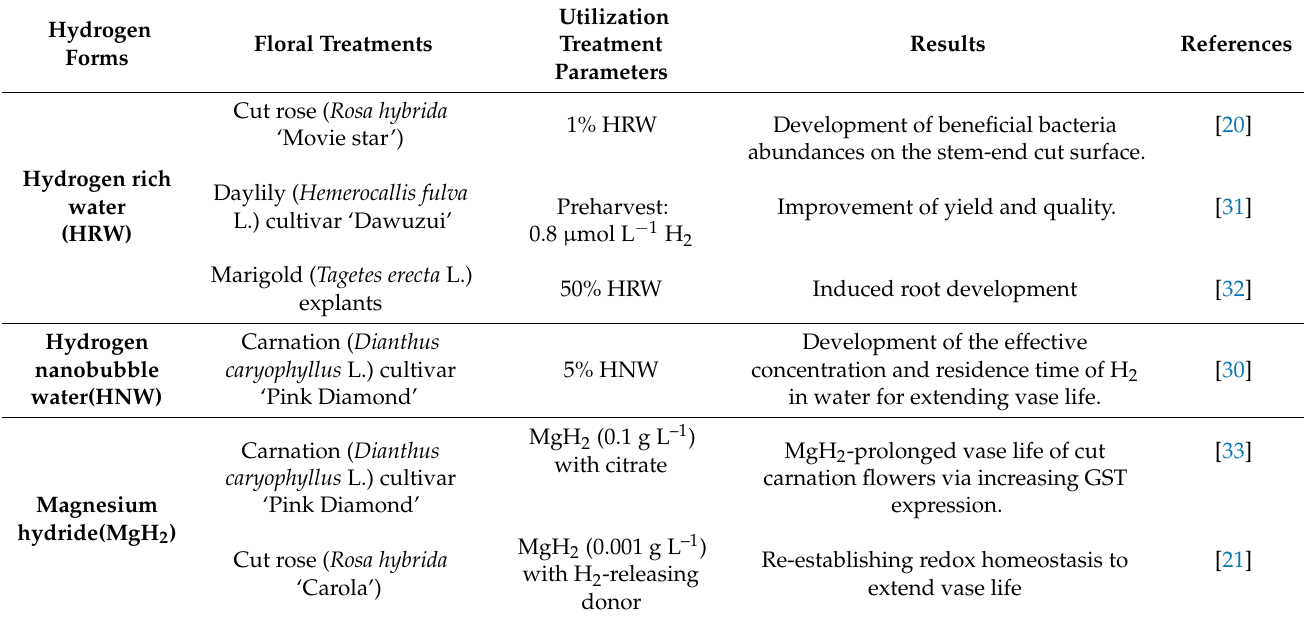
Table 1. An overview on the hydrogen forms used for floral